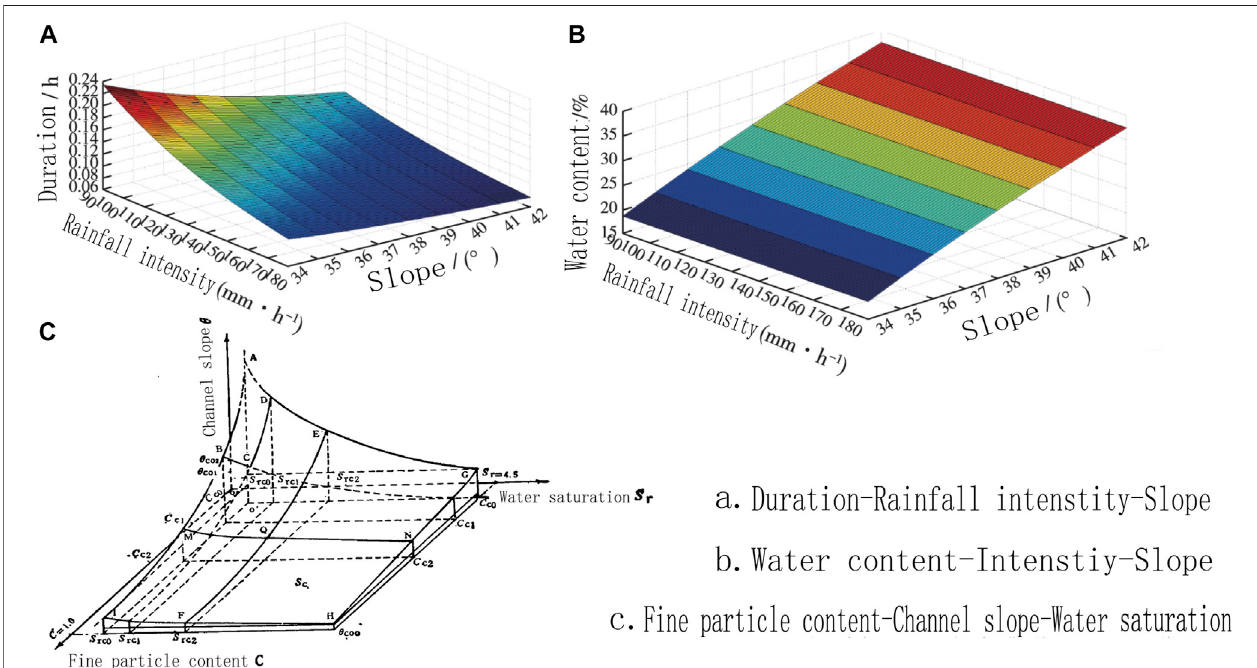
FIGURE 2 | Typical 3-dimensional discrimination models based on the key-element method ( (A) , (B) Qiao et al., 2018; (C) Cui, 1991).